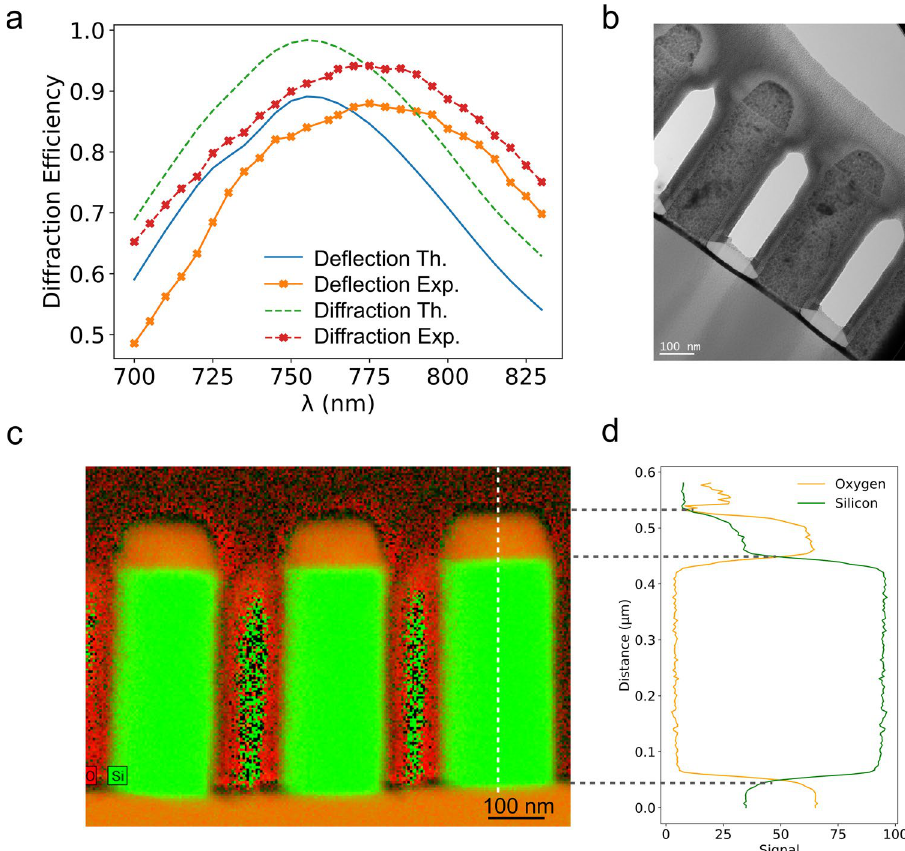
Figure 3. ( a ) Computed (solid and dashed line) and measured (symbols) metasurface diffraction and deflection efficiencies as a function of the wavelength of the incident plane wave. ( b ) TEM image of two silicon nanocylinders obtained by FIB cross section. ( c ) Elemental map measured by STEM-EDX showing the location of silicon and oxygen. ( d ) Elemental composition profile taken along the white dashed line visible in ( c